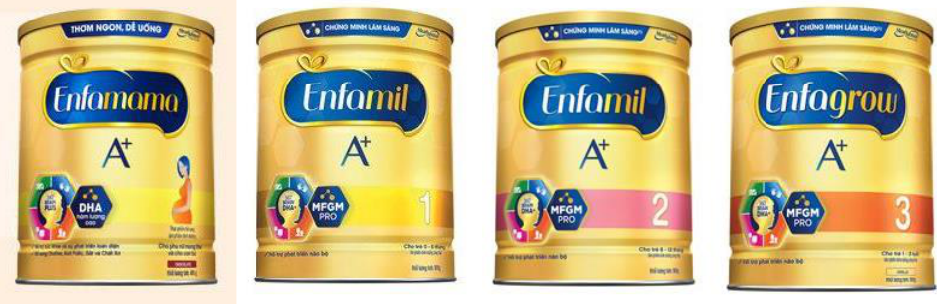
Figure 6. Cross-promotion of products in Enfa product line, with almost identical packaging and labeling [27].